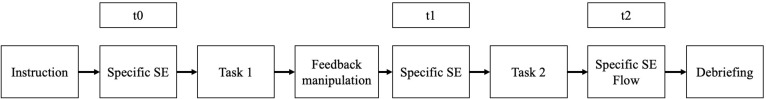
Study procedure.